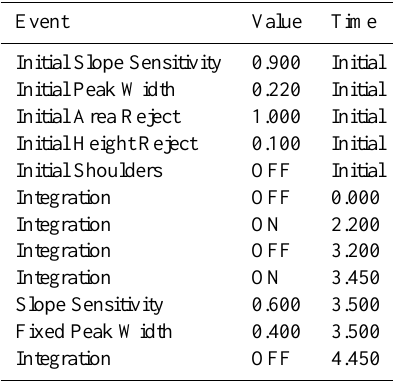
Table A3. FID integration events. Table A4. ECD integration